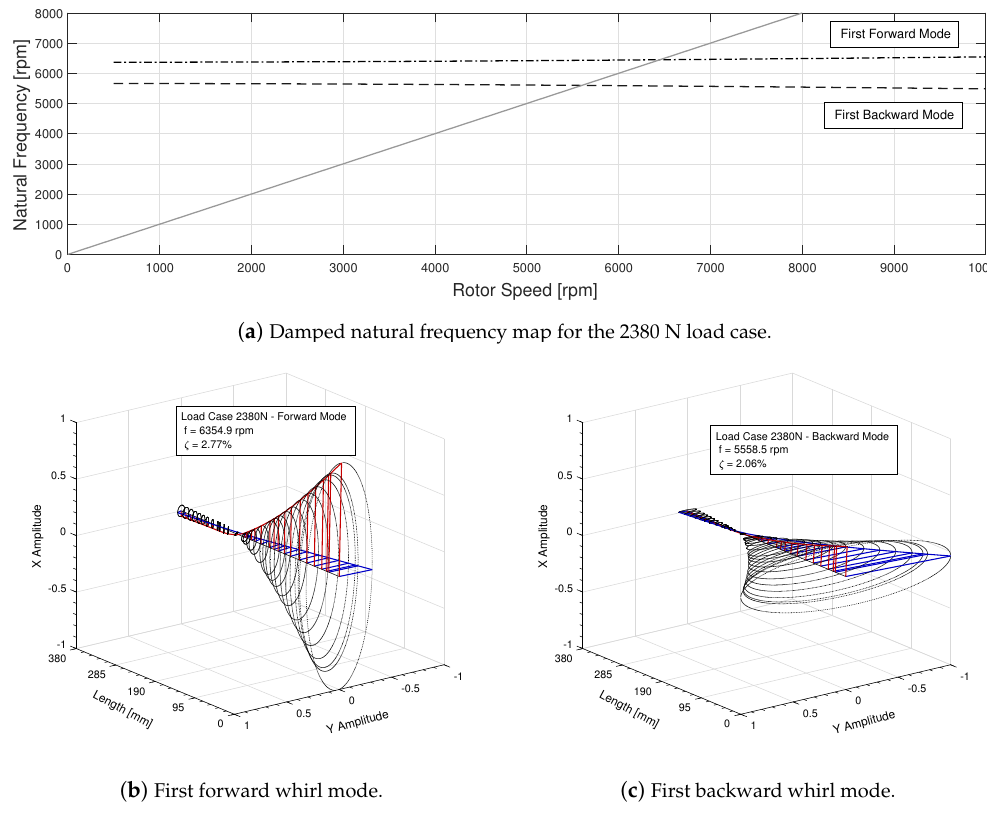
Figure 5. Results of the performed damped eigenvalue analysis for the 2380 N load case.